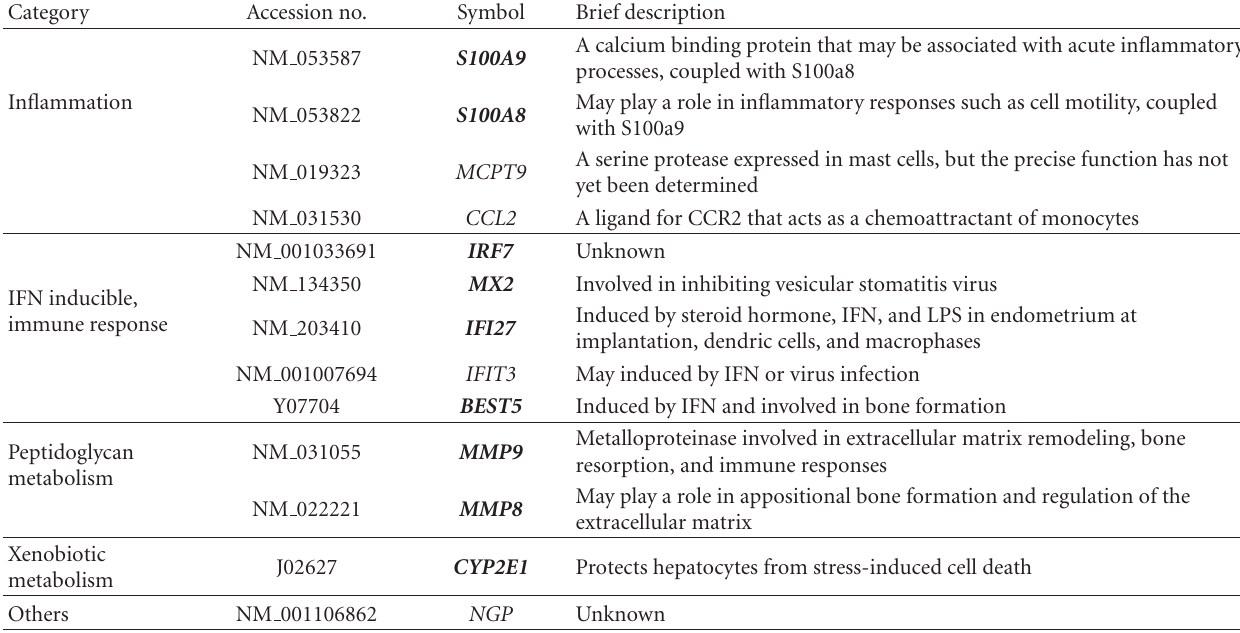
Table 1: Biomarkers for pertussis vaccine toxicity.